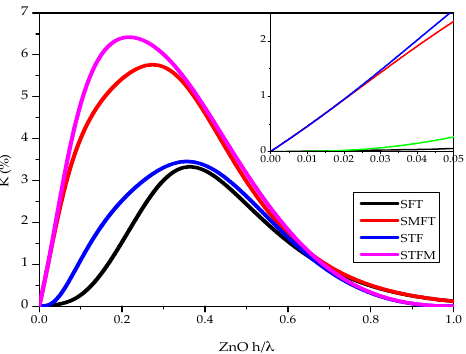
Figure 10. The K 2 vs. the ZnO thickness-to-wavelength ratio for the four coupling configurations. The a-SiC normalized thickness is fixed at h/ λ = 0.1.